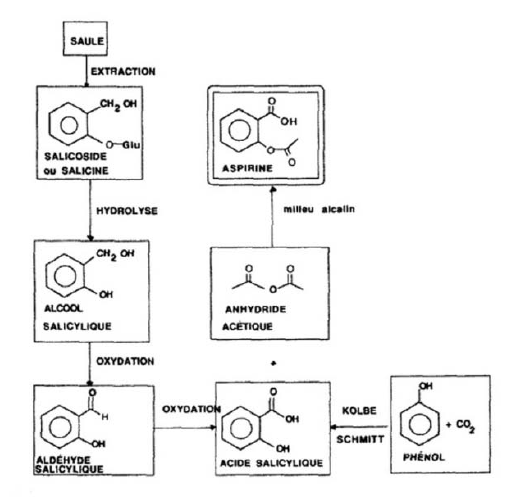
Figure 1. A synthetic route for acetylsalicylic acid by Hoffmann in 1897 [1].